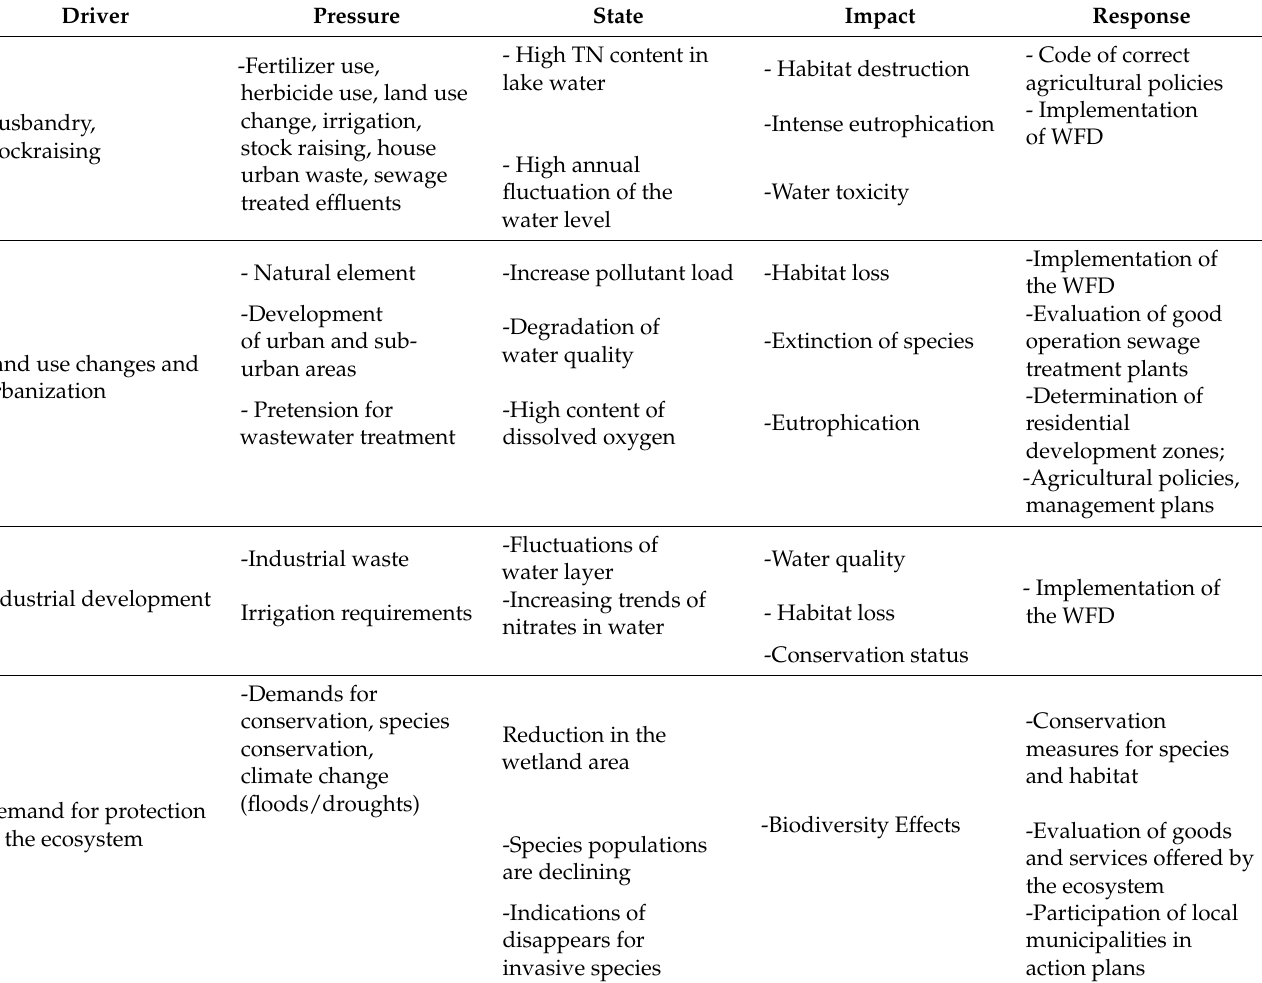
Table 5. Dataset of the applied DPSIR indicators in the lake